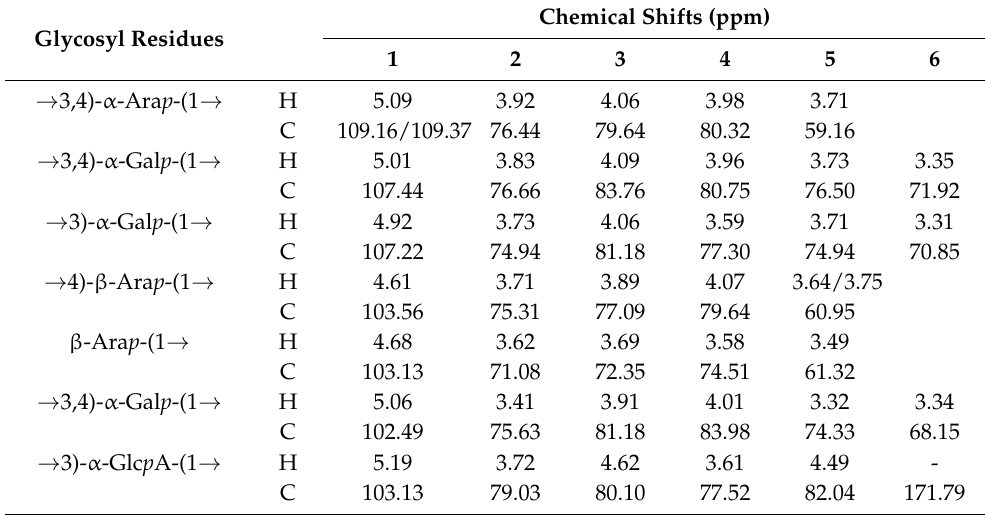
Table 5. Chemical shifts in resonances in the NMR spectra of